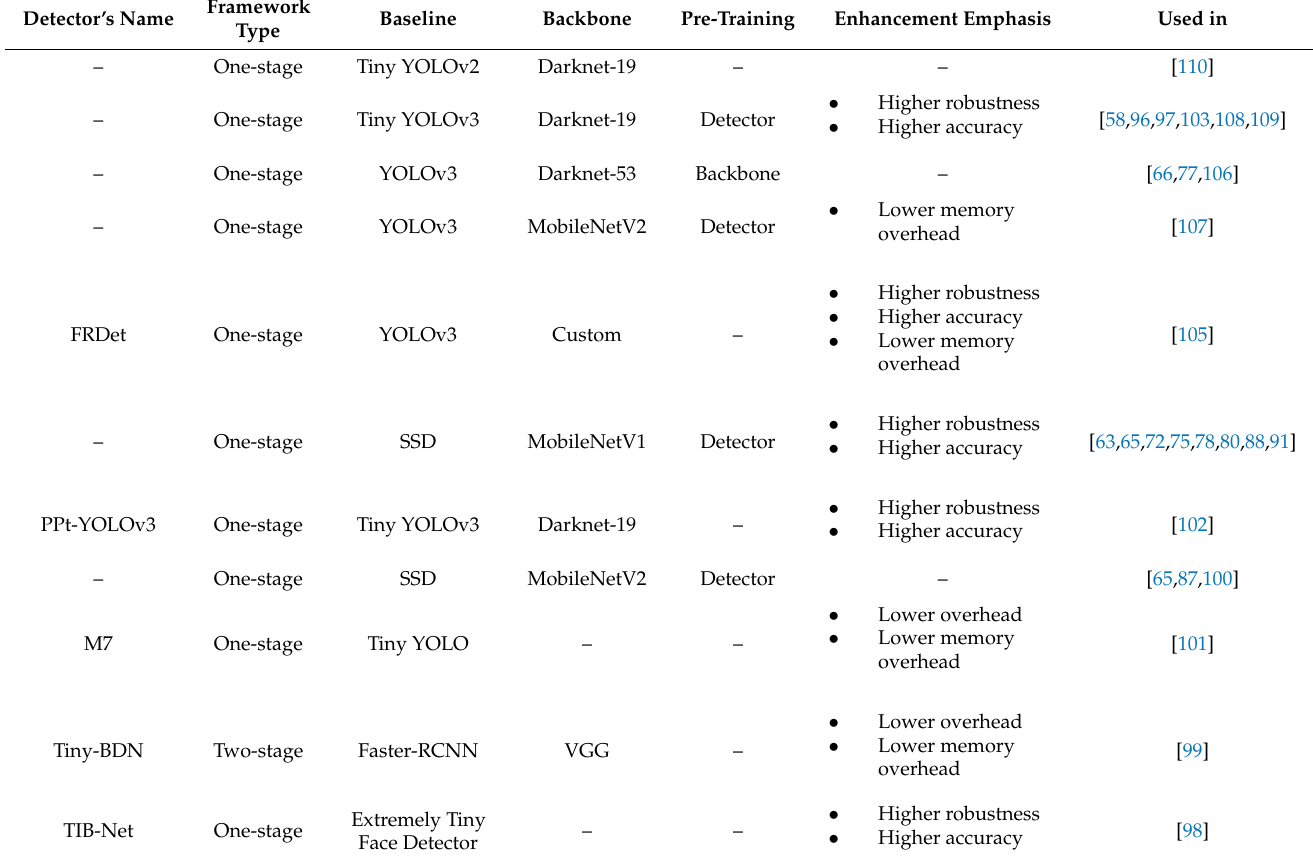
Table 2. Summary of the compact CNN-based object detection frameworks used in the research works considered. Detector’s